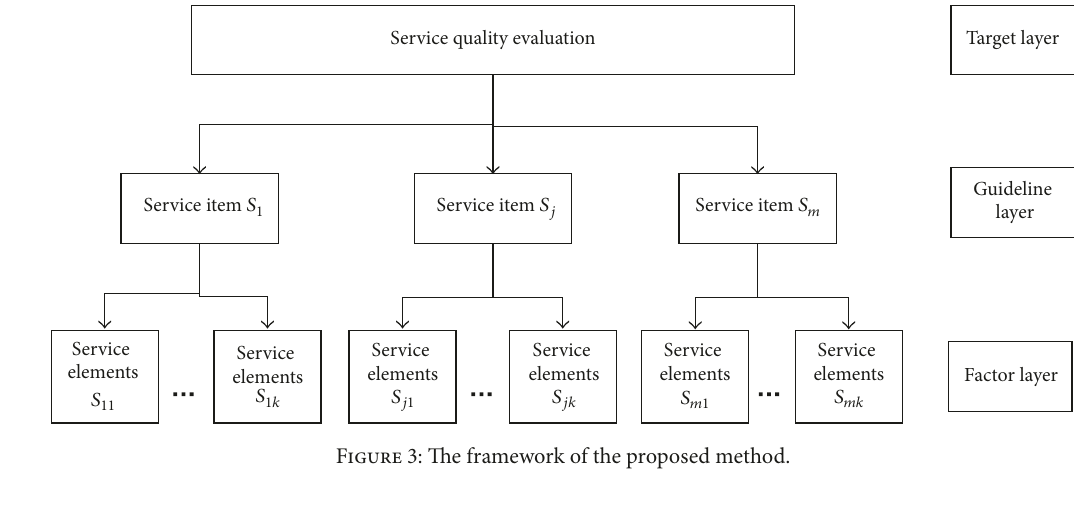
Table 1: AHP judgment scale definition